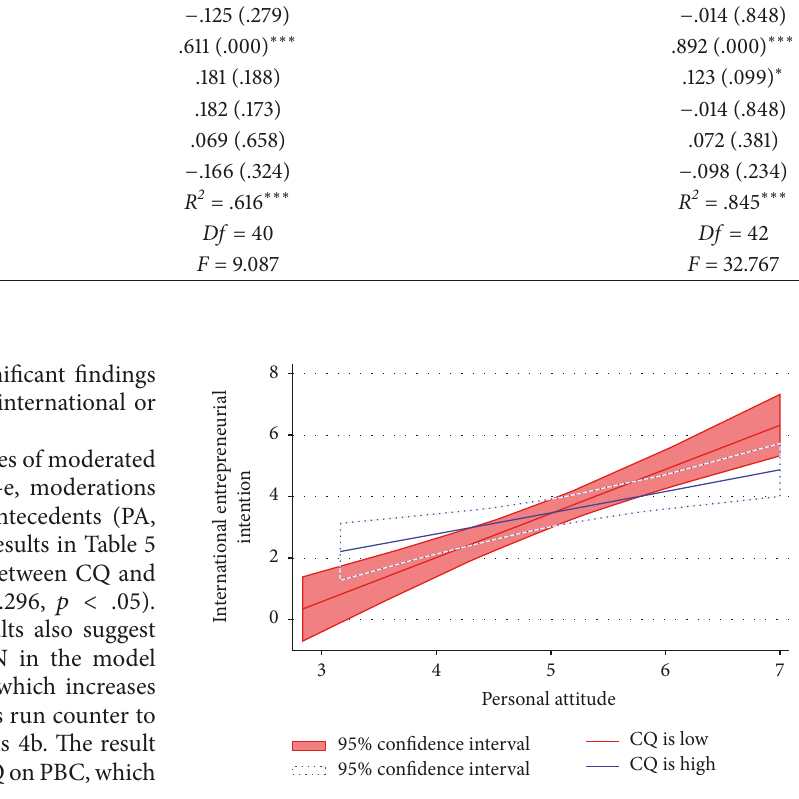
Figure 2: The interaction effect of CQ and PA on